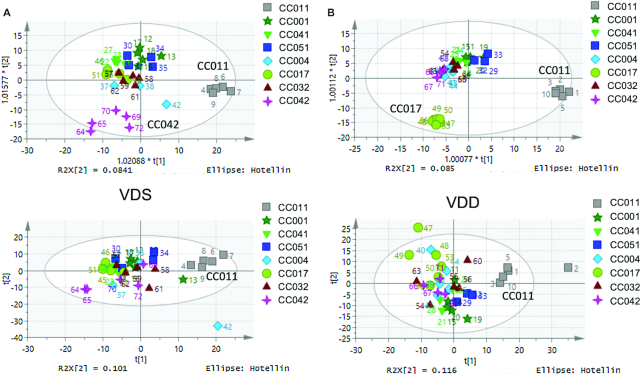
Strain effects on dam postweaning liver metabolomic profiles. Orthogonal partial least squares discriminant analysis (top row) and Principal Components Analysis (PCA) (bottom row) plots for strain stratified by diet: (A) VDS, (B) VDD. Each marker color and shape denotes a different strain. CC, Collaborative Cross; VDD, vitamin D deficient; VDS, vitamin D sufficient.